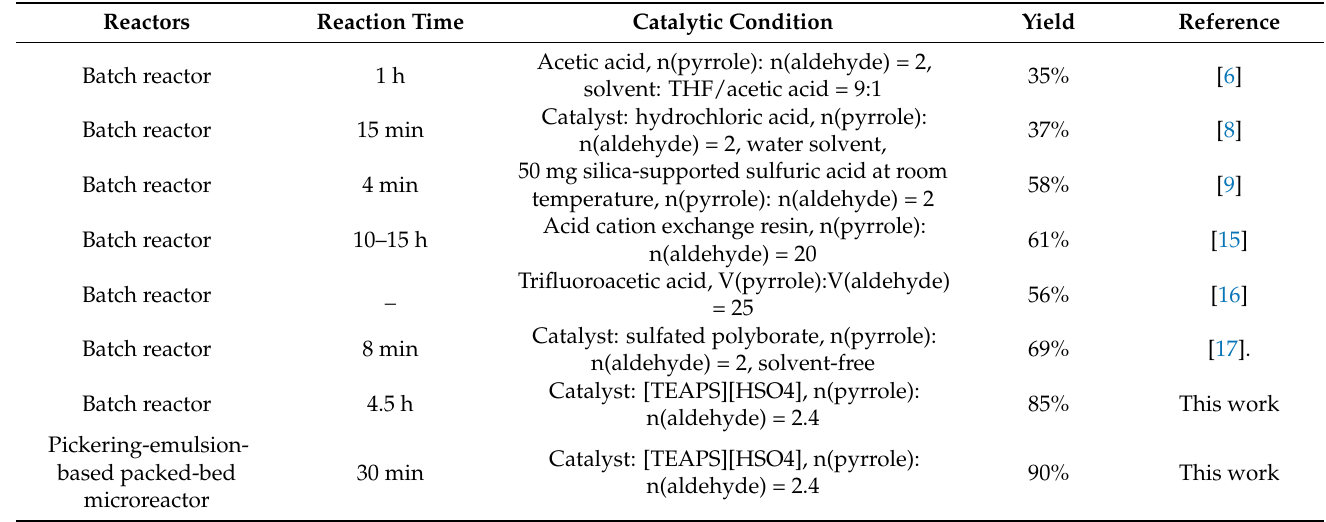
Table 1. Comparison between the Pickering-emulsion-based packed-bed microreactor and the batch reactors for the synthesis of 2,2 (cid:48) -(4-nitrophenyl)